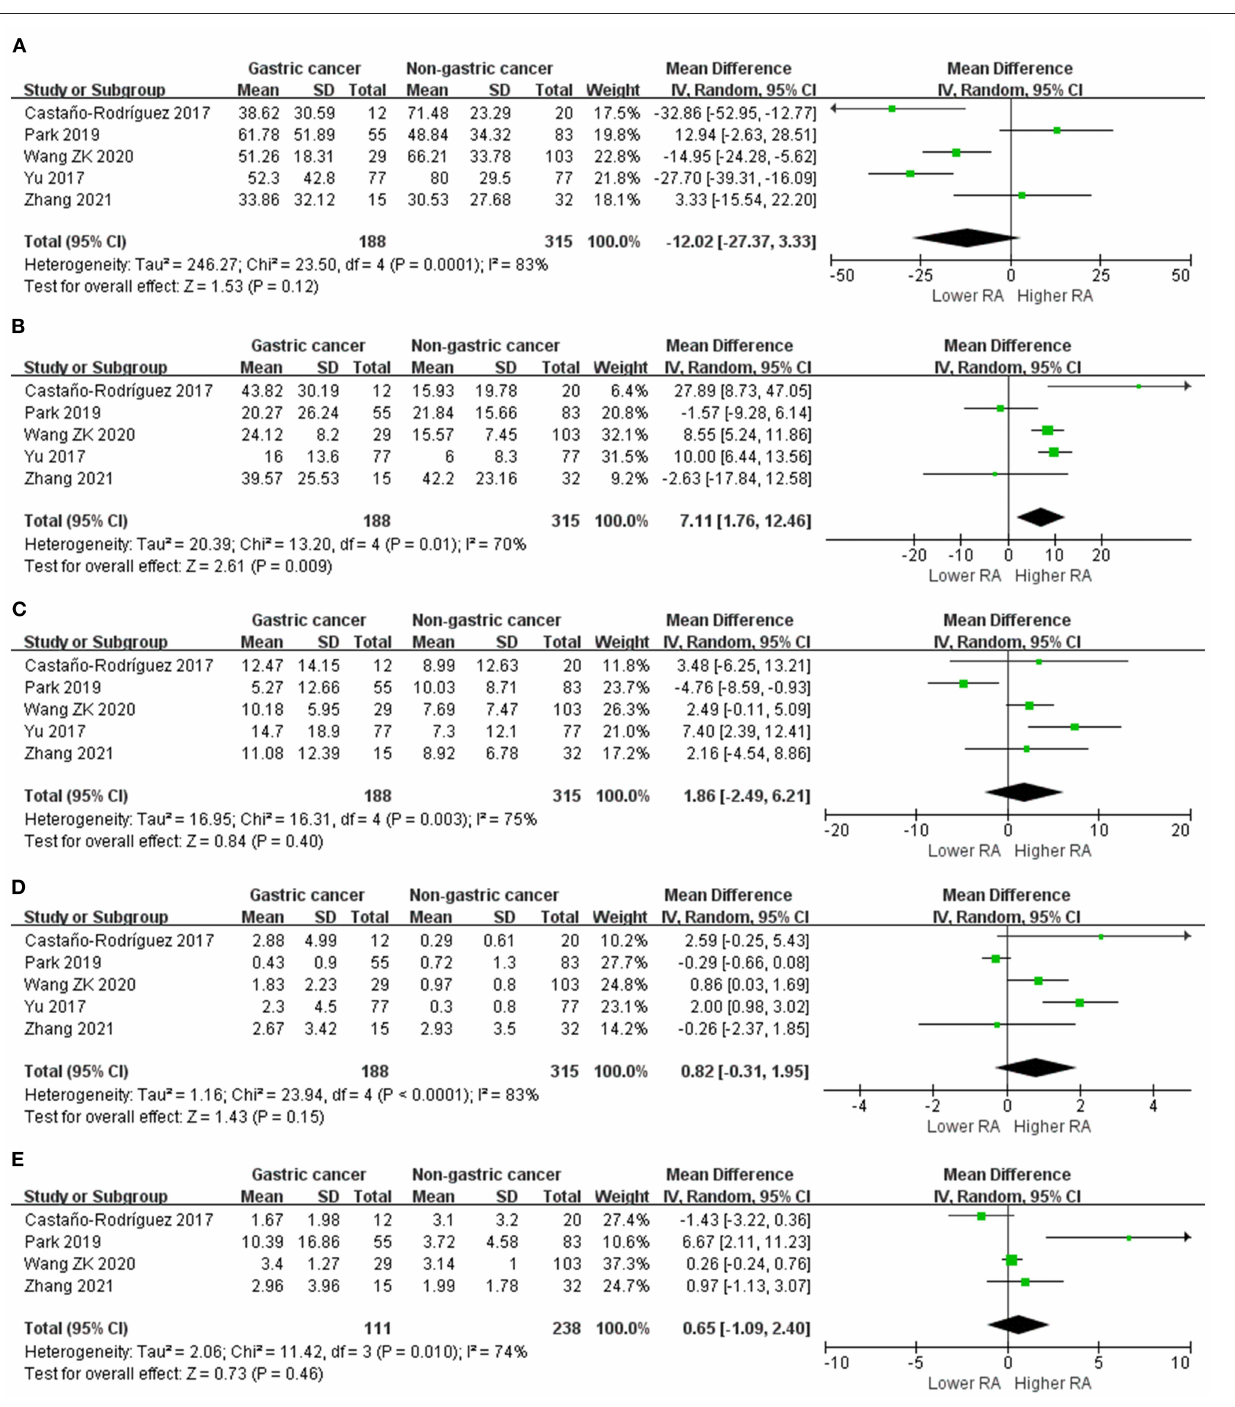
= 0.34, 95%CI: − 4.13 to 4.81) and Fusobacteria ( MD = 0.38, 95%CI: − 0.61 to 1.37) was not significant in the endoscopic